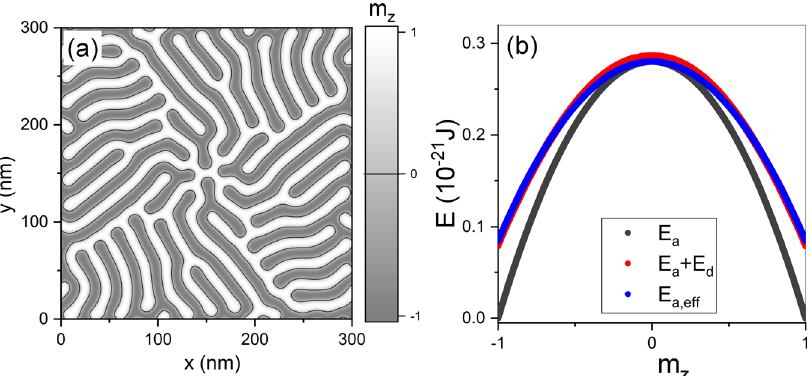
z . length scales. A new spin pro fi le of Θ ð r Þ ¼ 2 arctan tan along three triangular lattice directions, (1,0), (1/2, ffiffiffi p = 2), is proposed, where r labels the points on the yellow (1/2, (cid:3) 3 lines in Fig. 3a – c with r = 0 being the centre of a chosen sky- rmion. R and L are respectively the skyrmion size (the radius of m z = 0 contour) and the lattice constant. L relates to skyrmion number density n of an SkX in a triangular lattice as ffiffiffi p ¼ 22 : 11 nm for Fig. 3a, 19.90 nm for Fig. 3b, and L (cid:5) 1 : 07 = n 18.09 nm for Fig. 3c, where n is de fi ned as the total skyrmion number divided by the total fi lm area. Figure 3d – f are m z ( r ) along the yellow lines in Fig. 3a – c, respectively. Symbols are numerical data from MuMax3 simulations while the curves are m cos Θ with fi tting parameter R = 7.042 nm for Fig. 3d, 6.144 nm for Fig. 3e, 5.399 nm for Fig. 3f. R depends only on n , A / D , and κ .